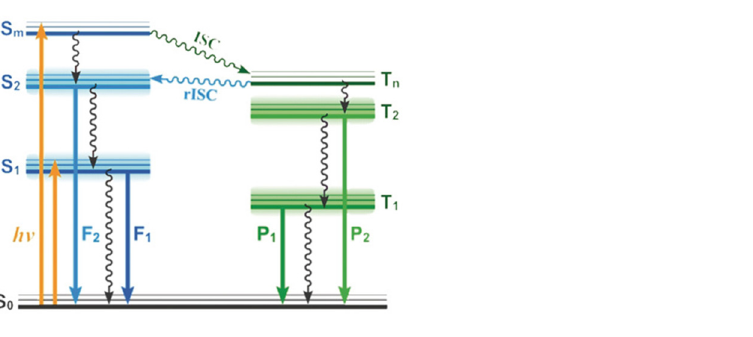
Figure 27. Suggested mechanism for the upper excited state fluorescence from neat solid 101 , 102 and 103 , based on DFT/TDDFT calculations. Adapted with permission from [85].